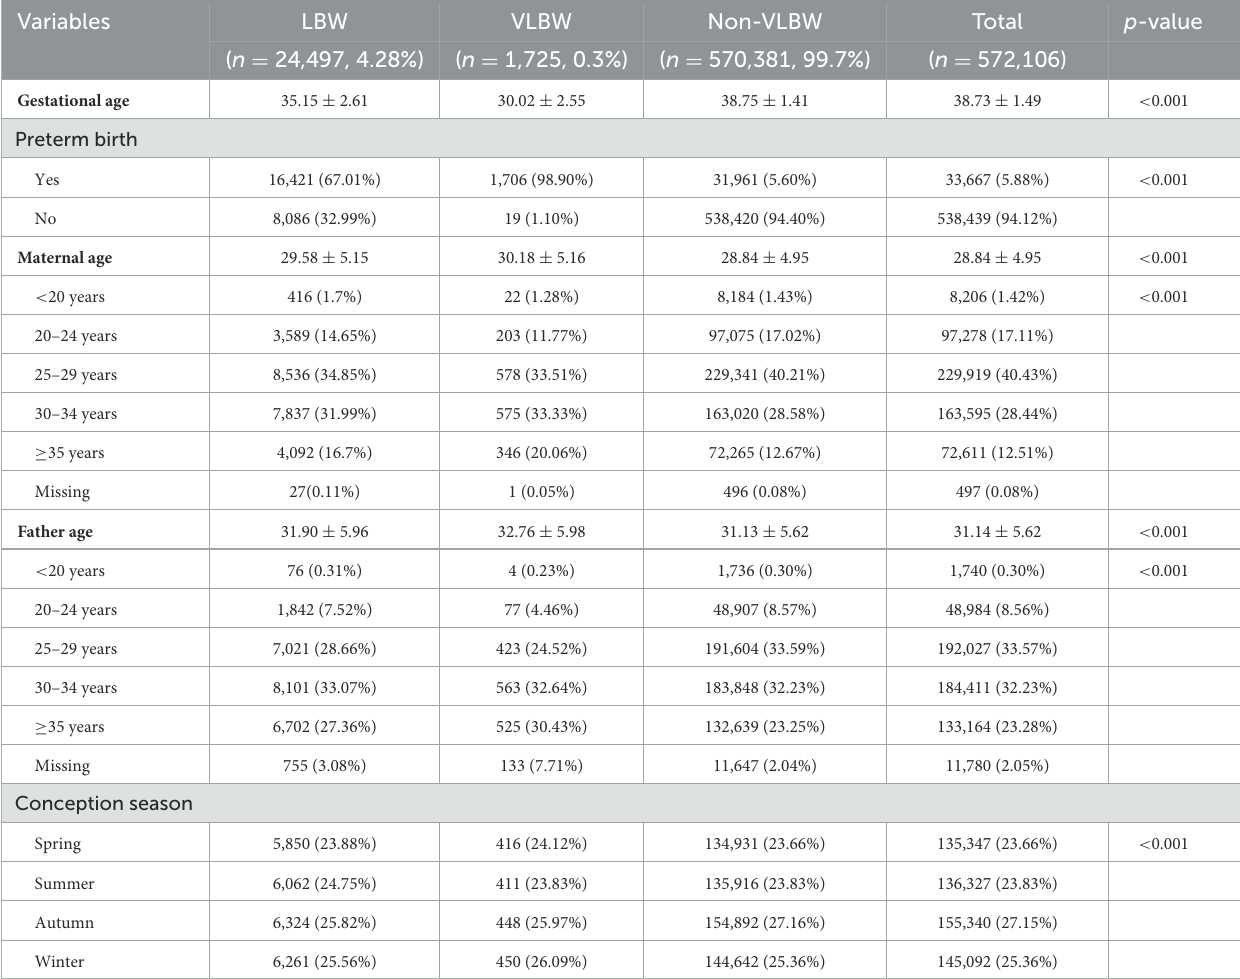
TABLE 1 Descriptive summary of the general characteristics of live birth